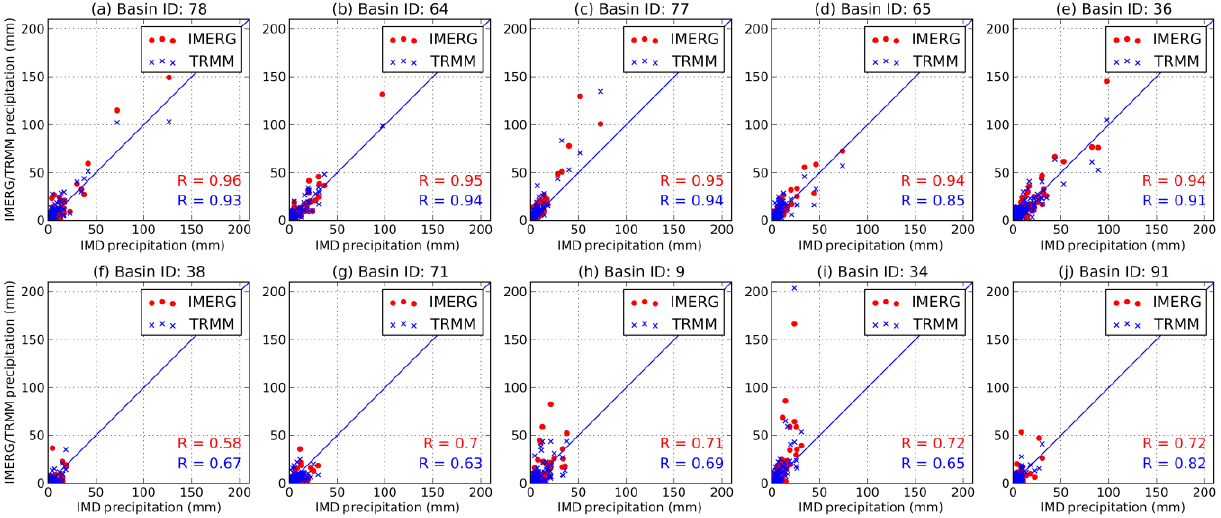
Figure 4. Scatter plot of satellite precipitation products (TRMM and IMERG) vs. observed rainfall (IMD) for the five best basins (a–e) in terms of correlation of IMERG with IMD (arranged in descending order) and the five worst basins (f–j) in terms of correlation of IMERG with IMD (arranged in ascending order) (based on daily precipitation data from 12 March to 31 December